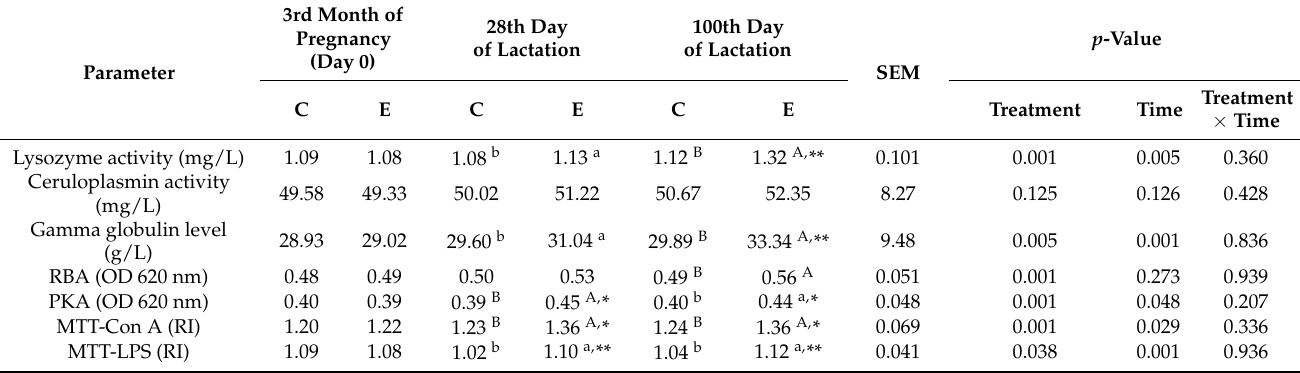
Table 5. Immunity parameters.